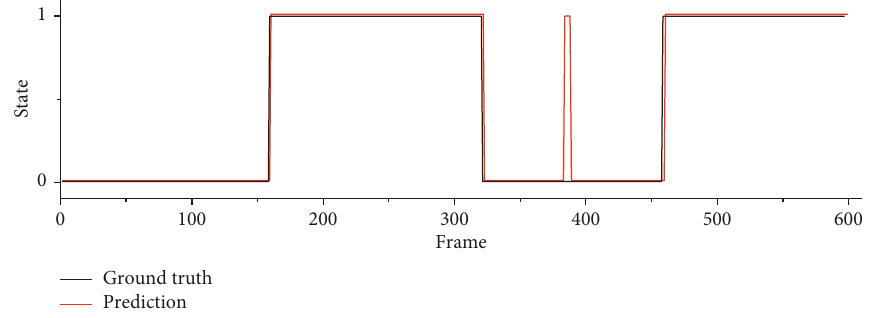
Figure 15: SVM prediction results.